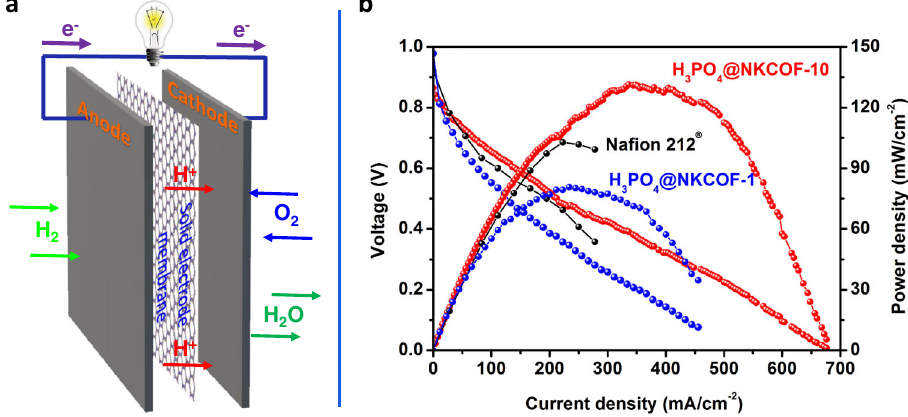
Fig. 5 Fuel cell of H 3 PO 4 @NKCOF-10. a Scheme of the PEMFCs using H 3 PO 4 @NKCOF-10, H 3 PO 4 @NKCOF-1, and Na fi on 212 as solid electrolyte membranes of MEA. b Polarization curves and power density curves obtained at 60 °C and 1.0 atm (H 2 and O 2 ) under 100% RH